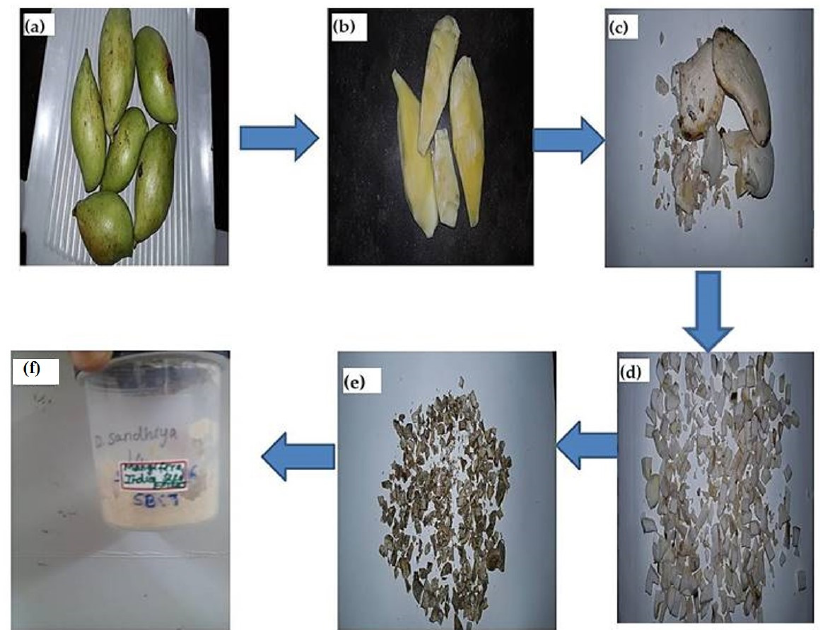
Figure 9. Preparation of mango seed extract. ( a ) Collection of raw mangoes ( b ) Collection of raw mango’s seed part ( c ) Mango seed part was cut into small pieces ( d ) Shade dried ( e ) Collection of shade dried mango’s seed part ( f ) Grounded to obtain coarsely powdered form.